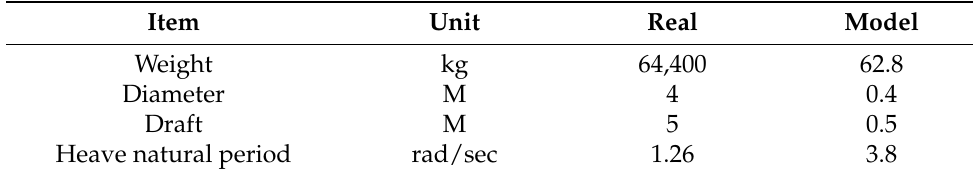
Table 1. Main particulars of the HPA (scale 1:10).